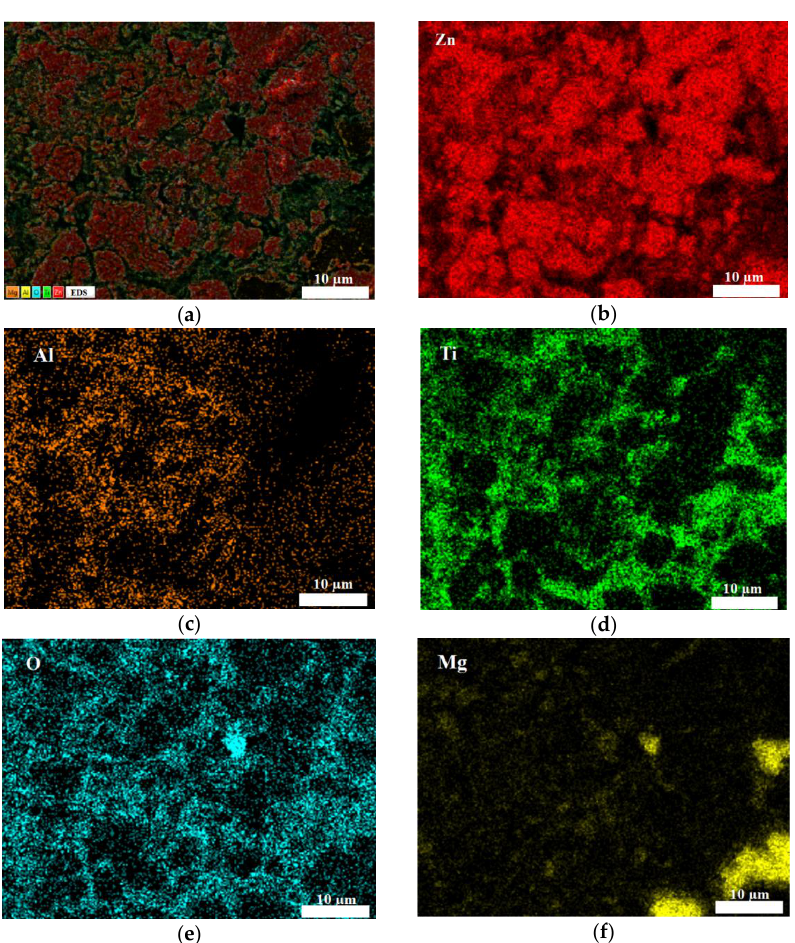
Figure 2. Energy dispersive spectrometer (EDS) mapping spectrogram of Figure 1a: ( a ) integrated mapping spectrogram; ( b ) Zn element mapping spectrogram; ( c ) Al element mapping spectrogram; ( d ) Ti element mapping spectrogram; ( e ) O element mapping spectrogram; ( f ) Mg element mapping spectrogram.